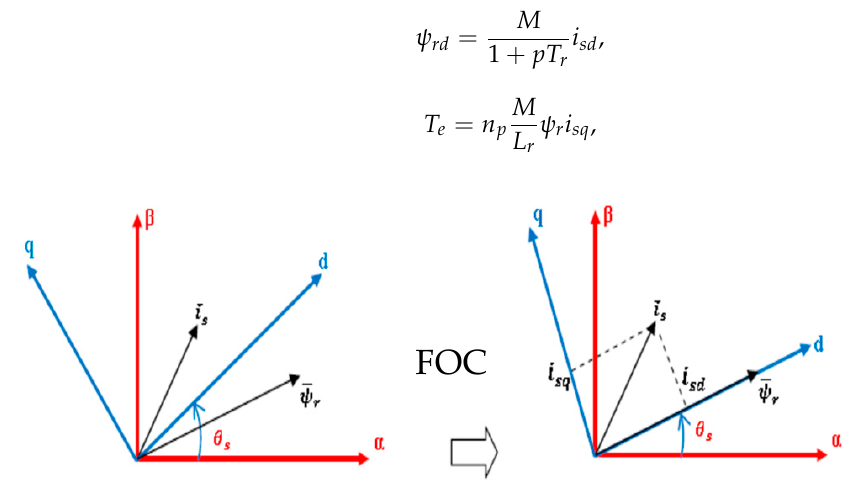
Figure 1. Orientation of the rotor field to d axis of the (d,q) reference.